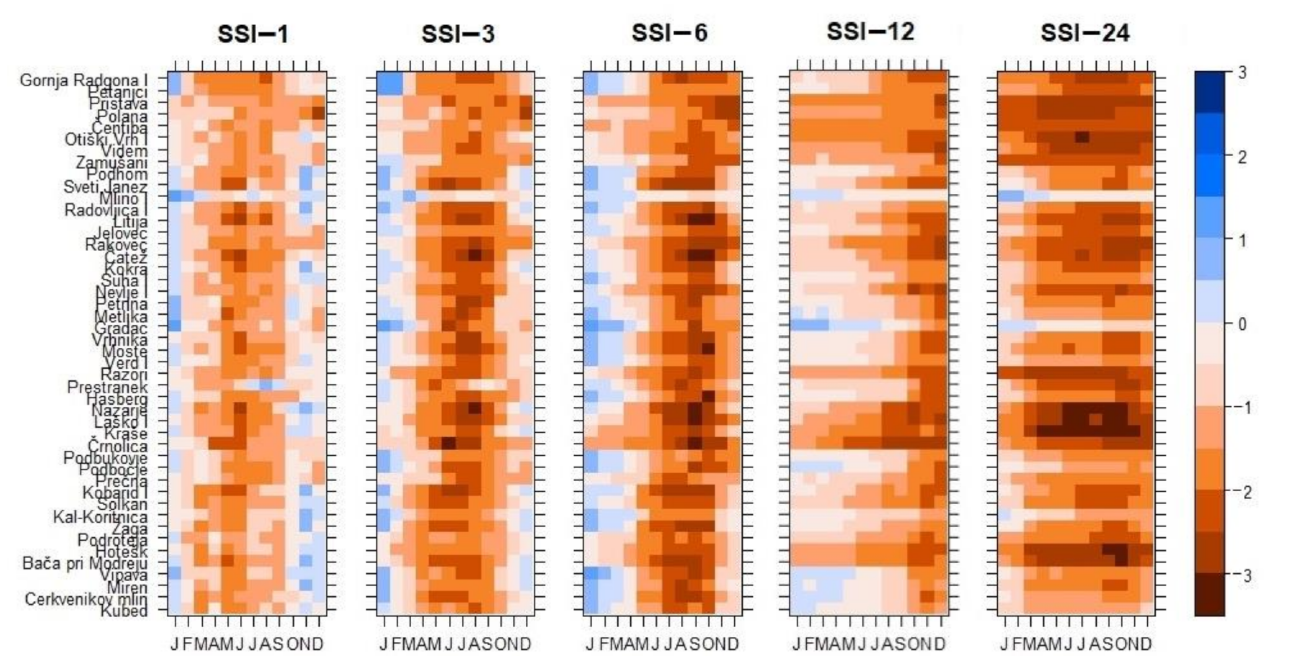
Figure 5. Seasonality of SSI results at various time scales (1, 3, 6, 12, and 24 months) for a dry year